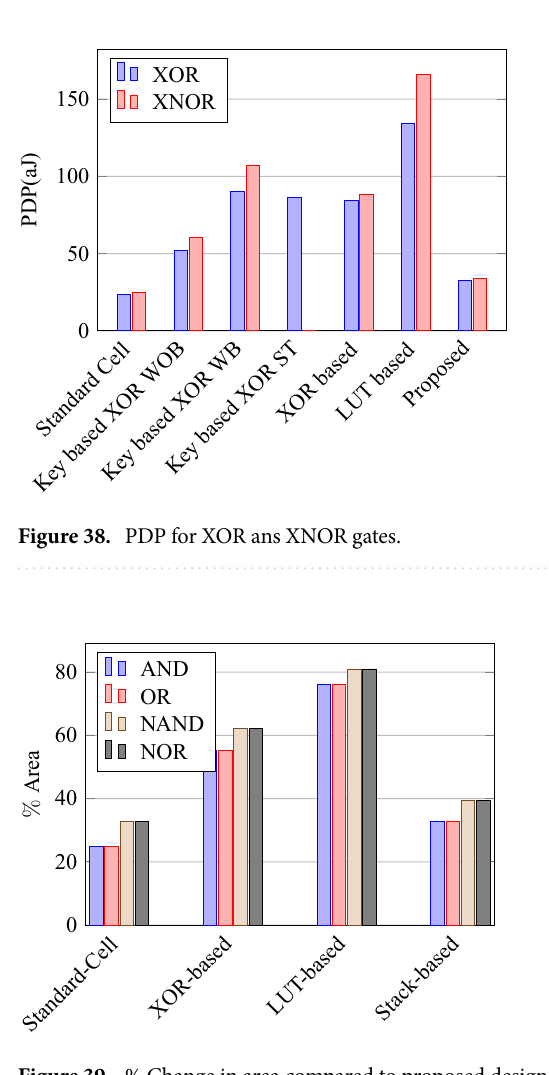
Figure 39. % Change in area compared to proposed